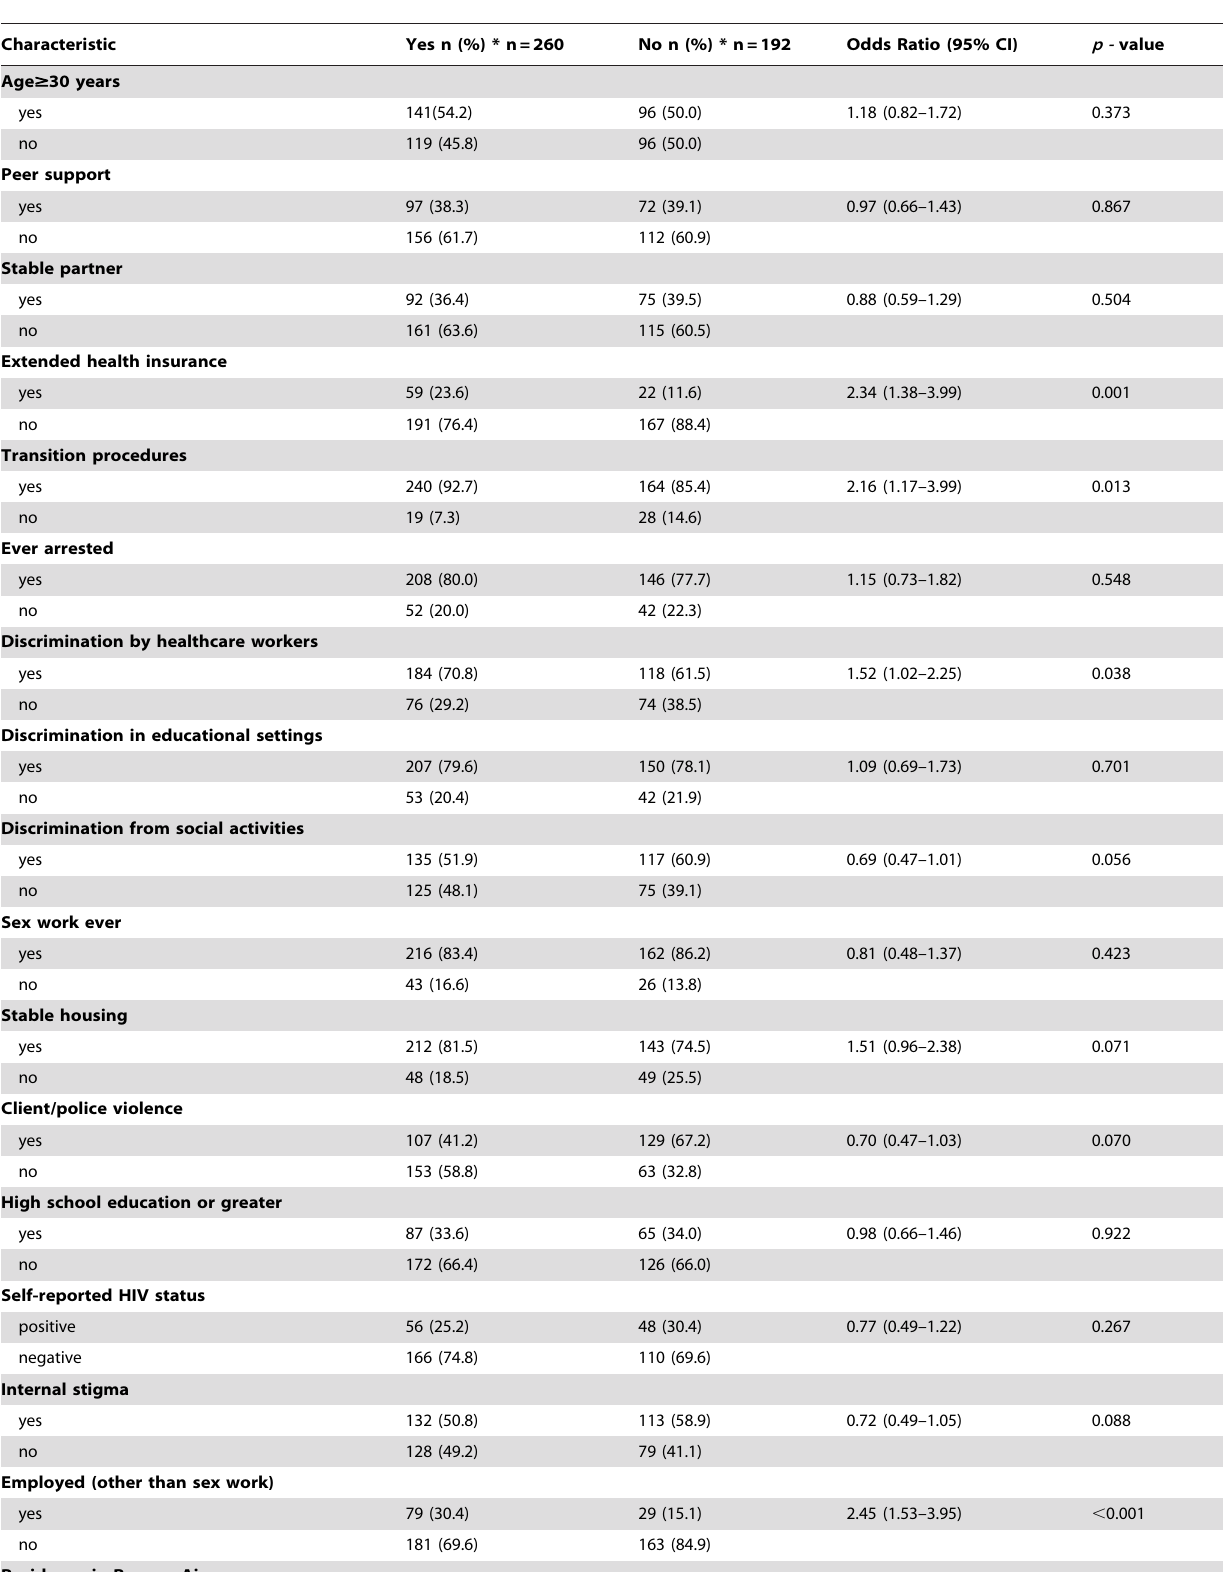
Table 1. Bivariate analysis of factors associated with acquiring a new gender-congruent ID among transwomen in Argentina